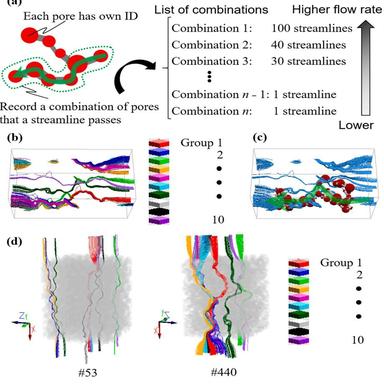
(a) Schematic of the method for defining high flowrate paths. (b) The top 10 highest flowrate paths are indicated in different colors. The groups are in descending order of the flowrate. (c) Overlapped image of the top 10 highest flowrate paths and the top 10 largest volume MR paths. Sample #440 is used in (b) and (c). (d) Visualization of the top 10 highest flowrate paths using samples #53 (lower inhomogeneity) and #440 (higher inhomogeneity). The solid phase is shown with increased transparency.